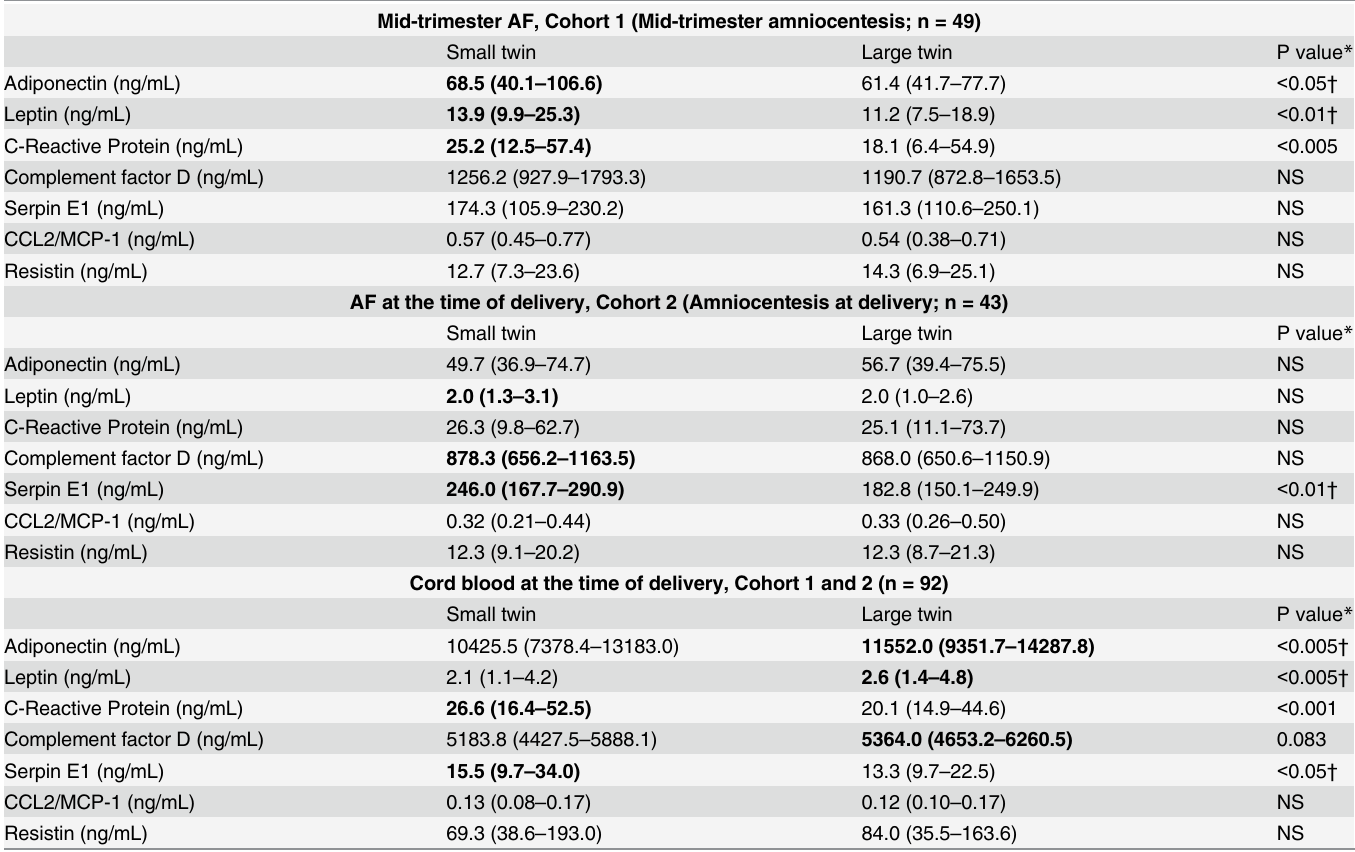
Table 2. Concentrations of select chemokines in smaller versus larger